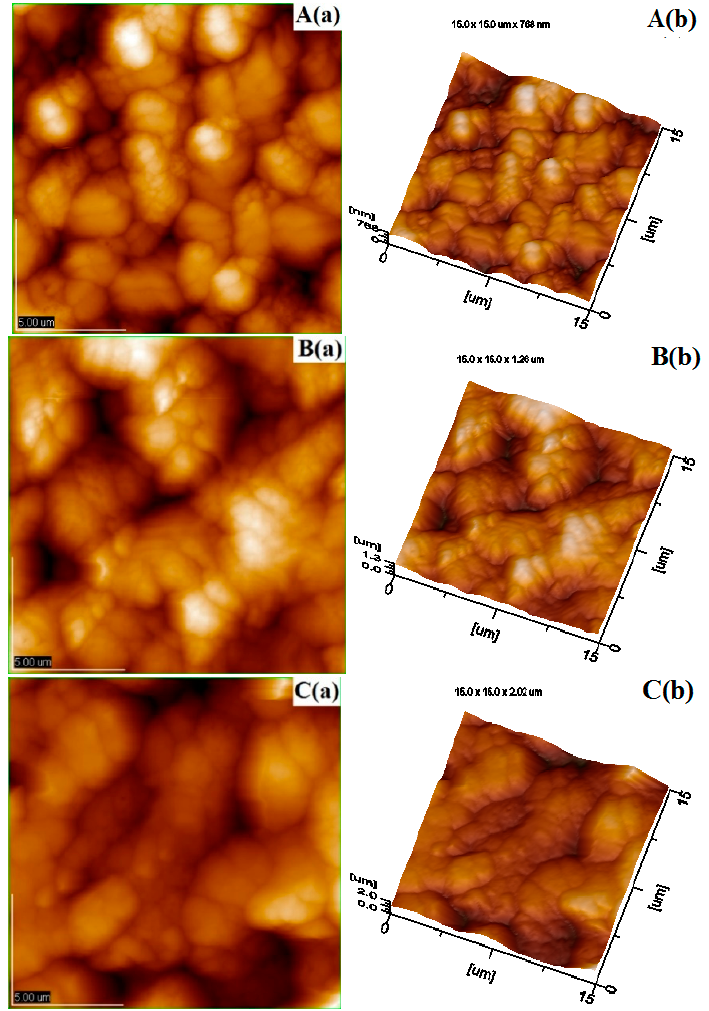
Figure 2. AFM analysis images for the morphology of chitosan coating (15 μ m × 15 μ m): ( A ) film with chitosan at 0.25%; ( B ) film with chitosan at 0.50%; and ( C ) film with chitosan at 1.0%, (a) AFM plane profile of chitosan film and (b) AFM three-dimensional profile of chitosan film.